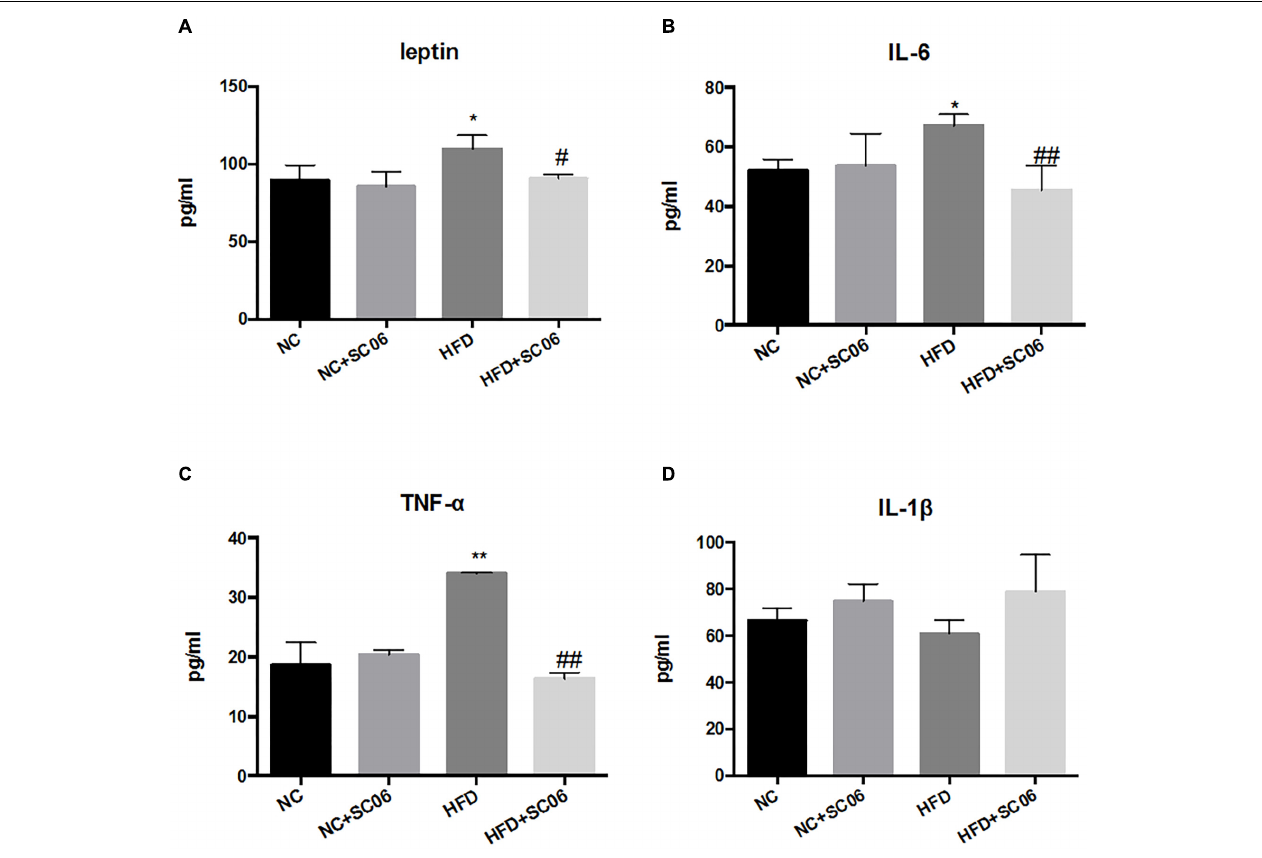
FIGURE 3 | SC06 modulated secretion of inflammatory factors and adipokine. (A) Leptin, (B) IL-6, (C) TNF- α , (D) IL-1 β . Results are expressed as means ± SD. Differences between groups were determined by one-way ANOVA followed by Tukey’s t -test ( n = 6). Significant differences between HFD versus NC are indicated as